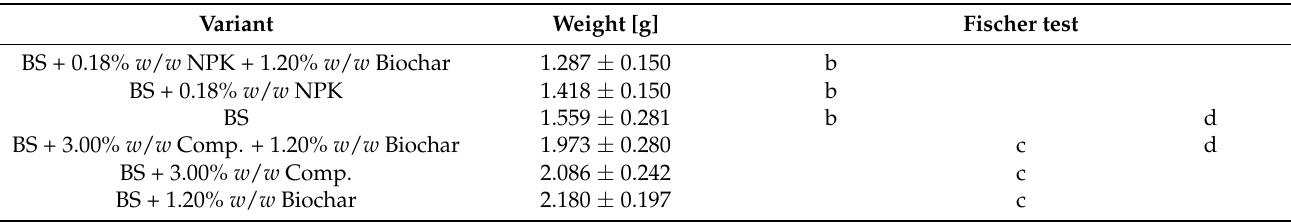
Table 3. Mean weight of AGB in individual variants.